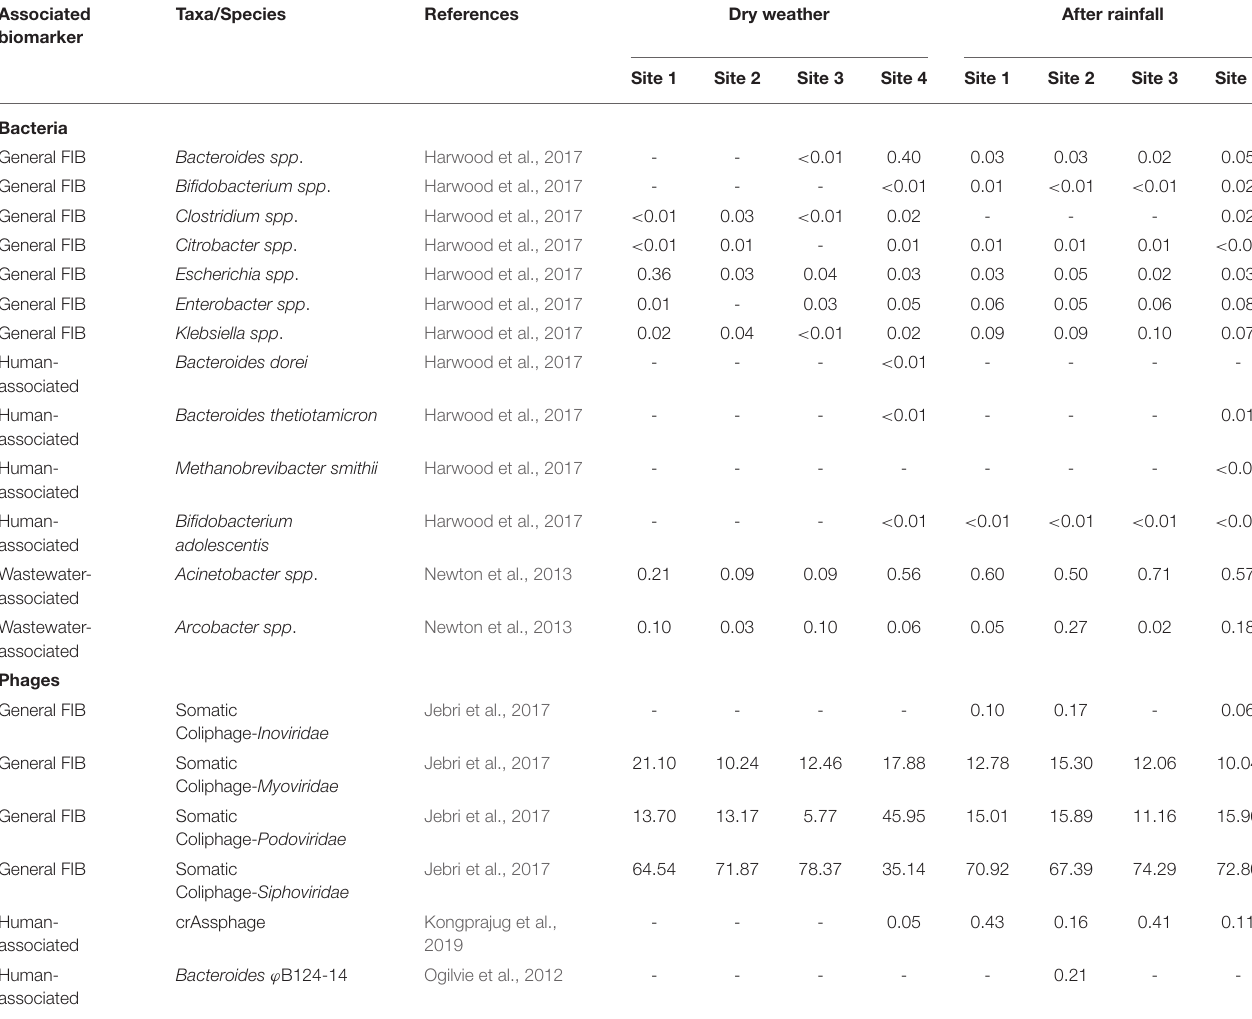
TABLE 3 | Relative sequencing read abundance of select general fecal indicators and human-associated microorganisms detected in urban watershed